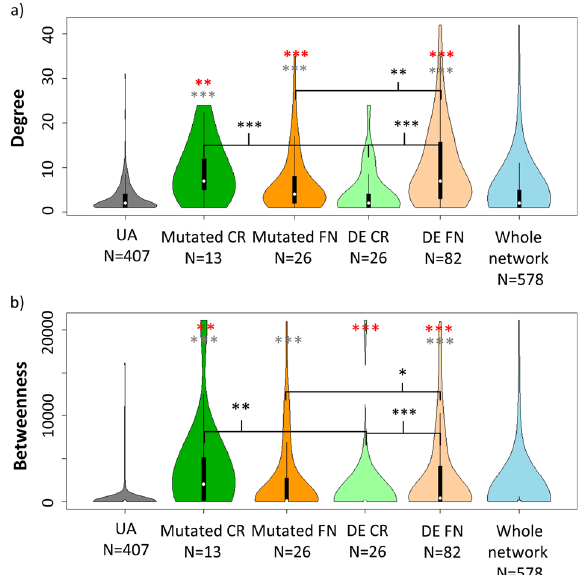
Fig. 2 Differences between fi rst neighbours of mutated and differentially expressed proteins in colon cancer. a , b Violin plot showing the degree and betweenness centrality of mutated or differentially expressed (DE) cancer-related (CR) proteins and their respective fi rst neighbours (FN) to unaffected proteins (UA) or to the whole network in the signalling network of colon cancer (using the SignaLink 2 database). White dots represent the median values. Boxes stretch from the 25th percentile to the 75th percentile, while the whiskers are twice the length of the boxes. Wilcoxon rank sum tests was employed for the statistical analysis, with the unaffected proteins ( grey stars) and the whole colon cancer speci fi c network ( red stars) as control. The level of signi fi cance is represented using the following scale: * p < 0.05, ** p < 0.01, *** p < 0.001. The plots show that FN of DE proteins have higher network centralities